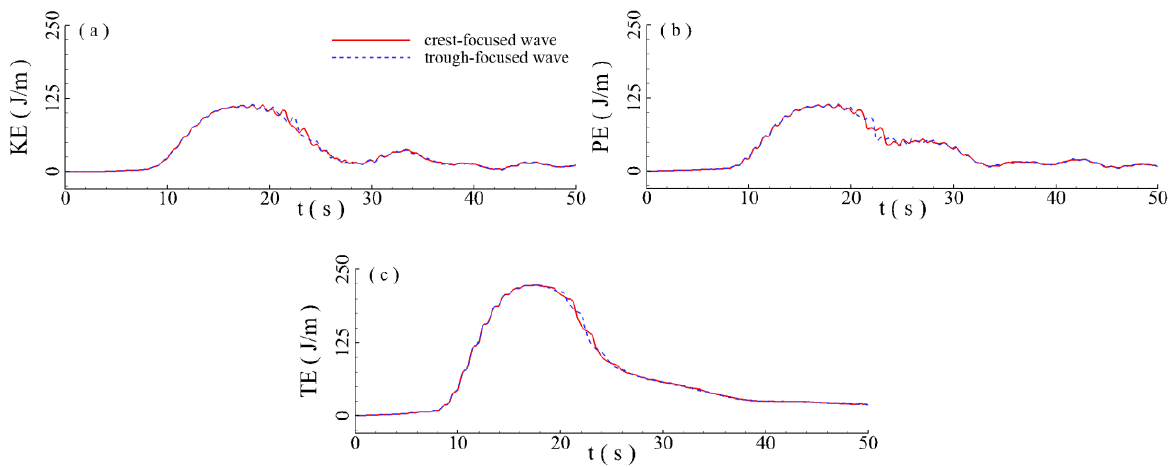
Figure 14. Comparisons of the water wave energies in the whole computational domain; ( a ) ki- netic energy; ( b ) potential energy; ( c ) total wave energy.